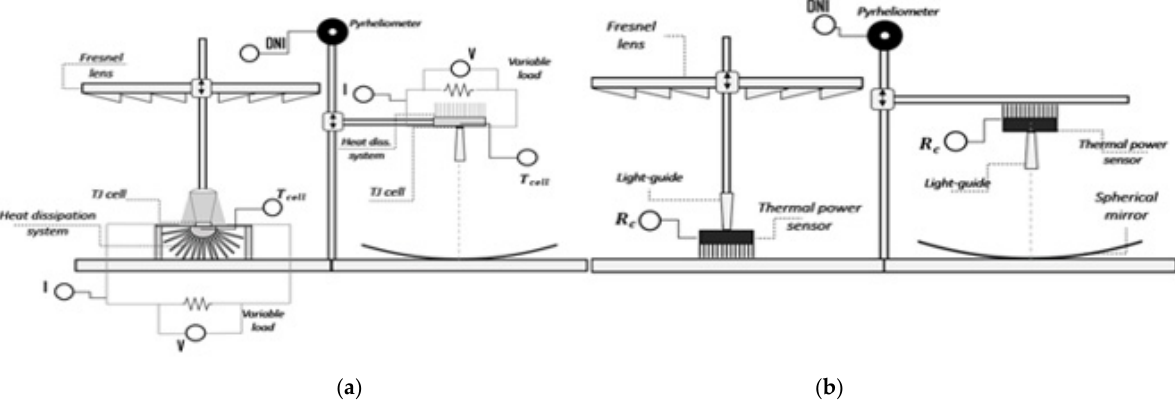
Figure 2. Plant scheme with measurement instruments: TJ cell ( a ) and thermal power sensor ( b ).